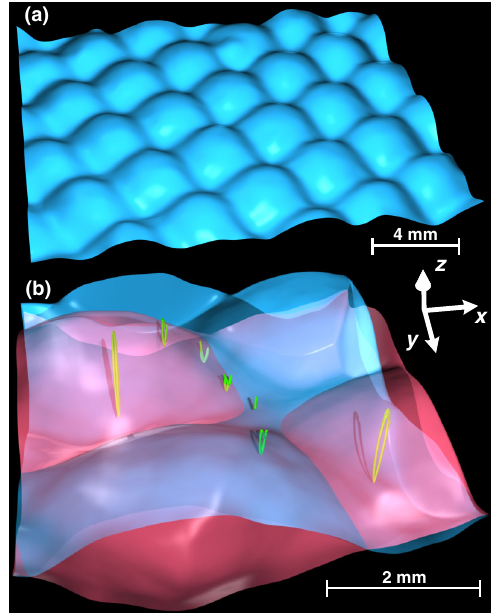
FIG. 7. Perspective view of three-dimensional particle trajecto- ries in a FW crystal. FW are excited at the surface of a solution of 73% glycerol þ 10% milk þ water (no added surfactant). ¼ 2 . 6 g , ϵ ¼ 0 . 08 ) at The vertical acceleration is a ¼ 2 . 8 g ( a th f 0 ¼ 60 Hz. (a) Waves showing a crystalline pattern. (b) Close-up of 3D particle trajectories followed for 8 Faraday periods ≈ 264 ms) at thewavelength scale. Pink and bluewave fields ( 8 T f correspond to two consecutive phase extrema of the waves, which are thus separated in time by one period of the shaker oscillation (Faraday waves are parametrically excited